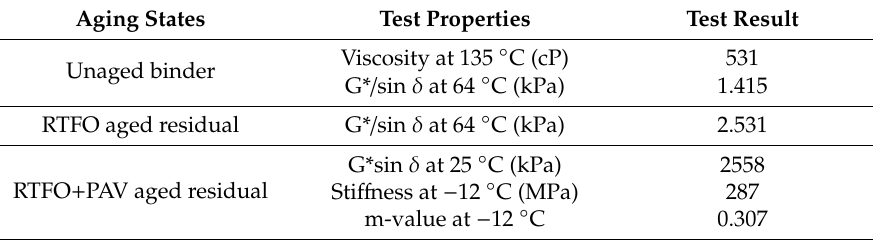
Table 1. Properties of base asphalt binder (PG 64-22)